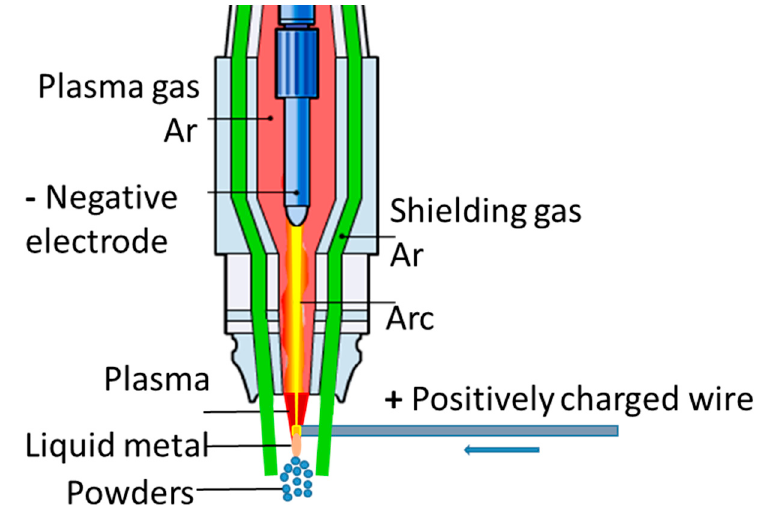
Figure 5. Diagram of plasma wire dispersion.